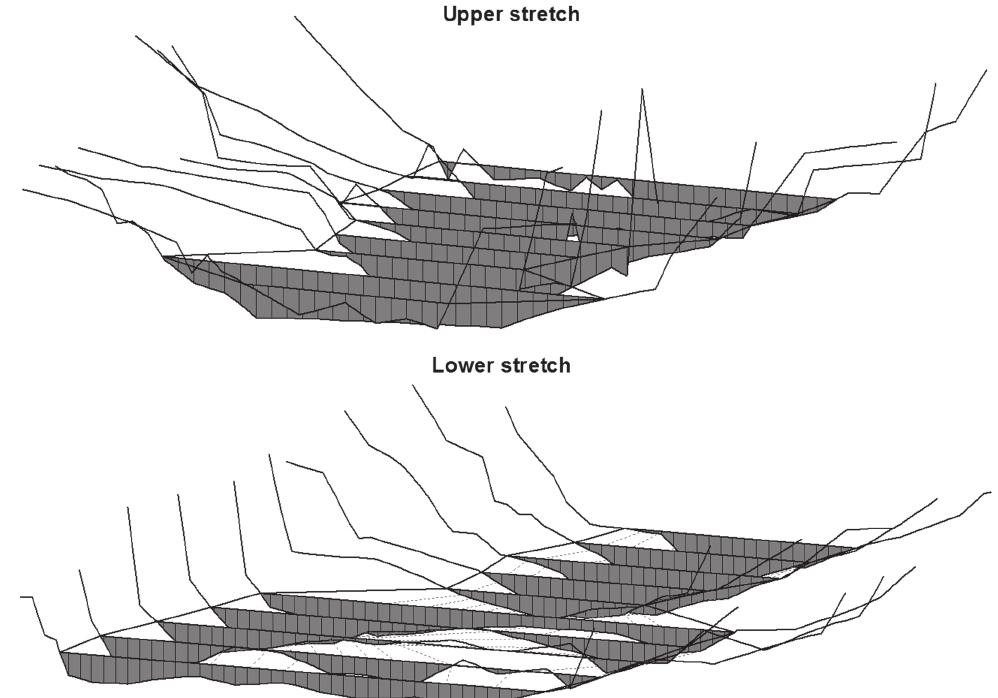
Fig. 2 . Isometric view of the cross-sections in the two target reaches of the riacho São Pedro. Grey color indicates water; solid line indicates the contour of the cross-section (in wet areas and